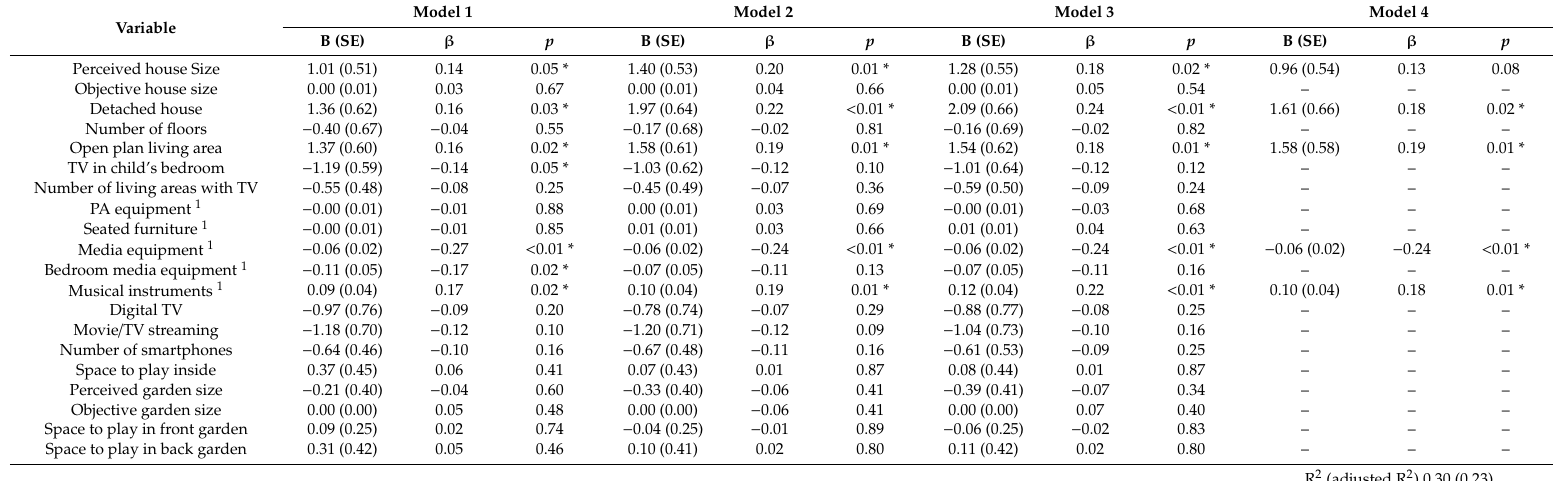
Table 3. Associations between physical home factors and children’s home-based